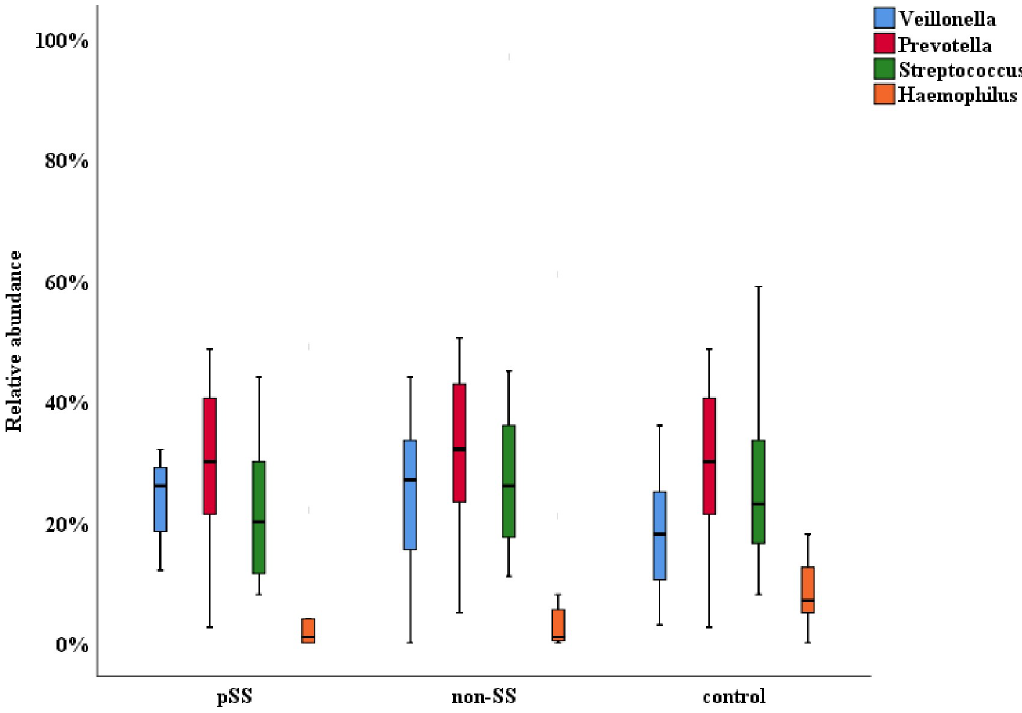
Fig 2. Relative abundance of the major bacterial genera in saliva from pSS, non-SS, and control